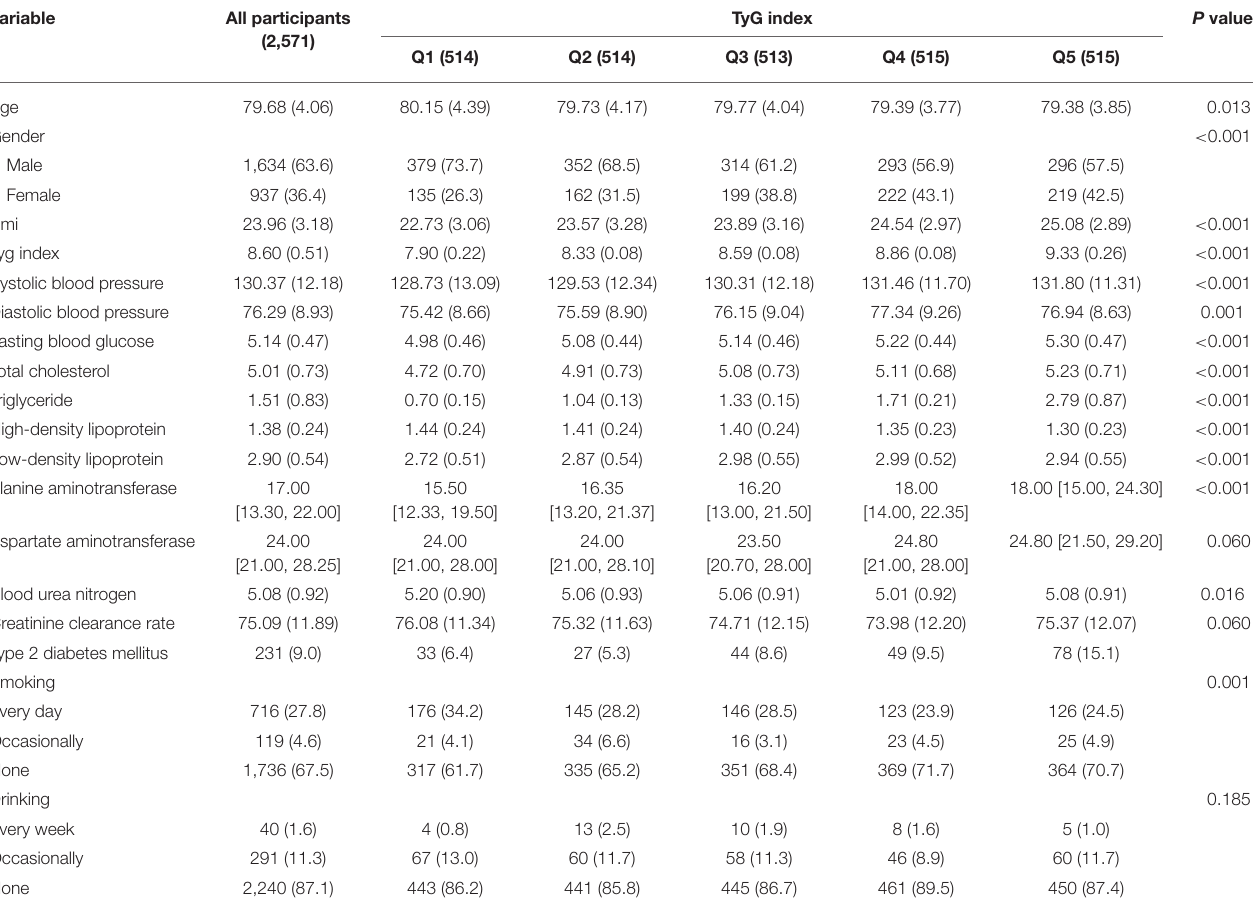
TABLE 1 | Baseline characteristics of the